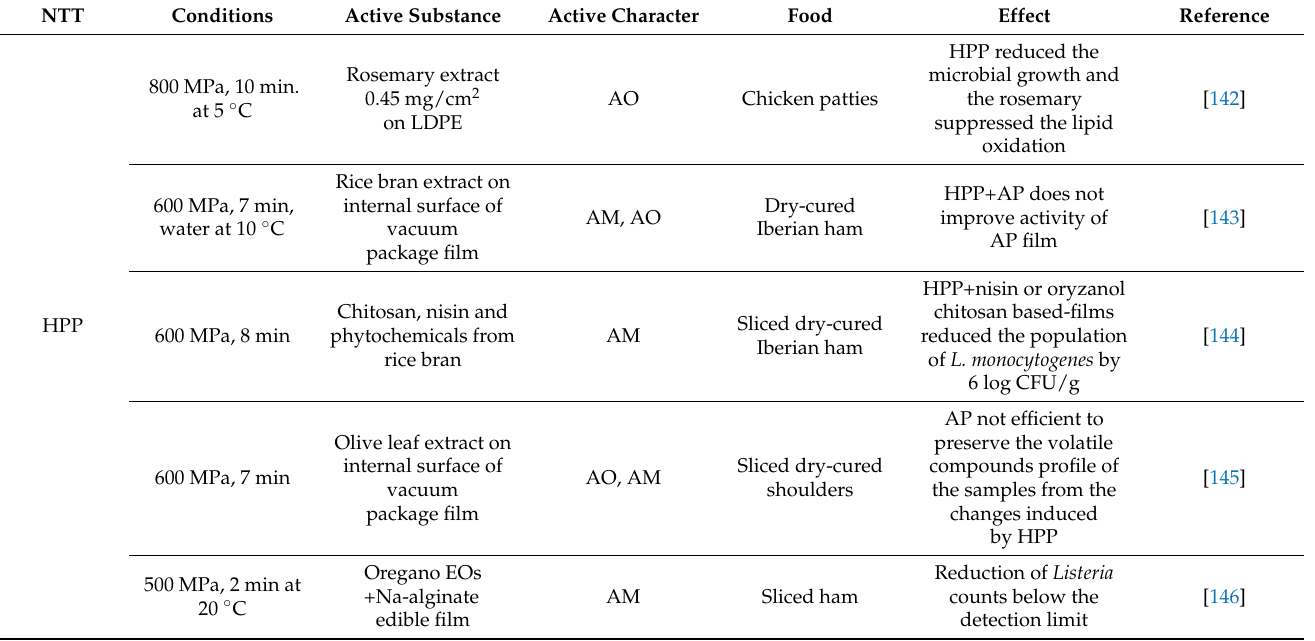
Table 3. Effect of non-thermal treatments on active packaging material